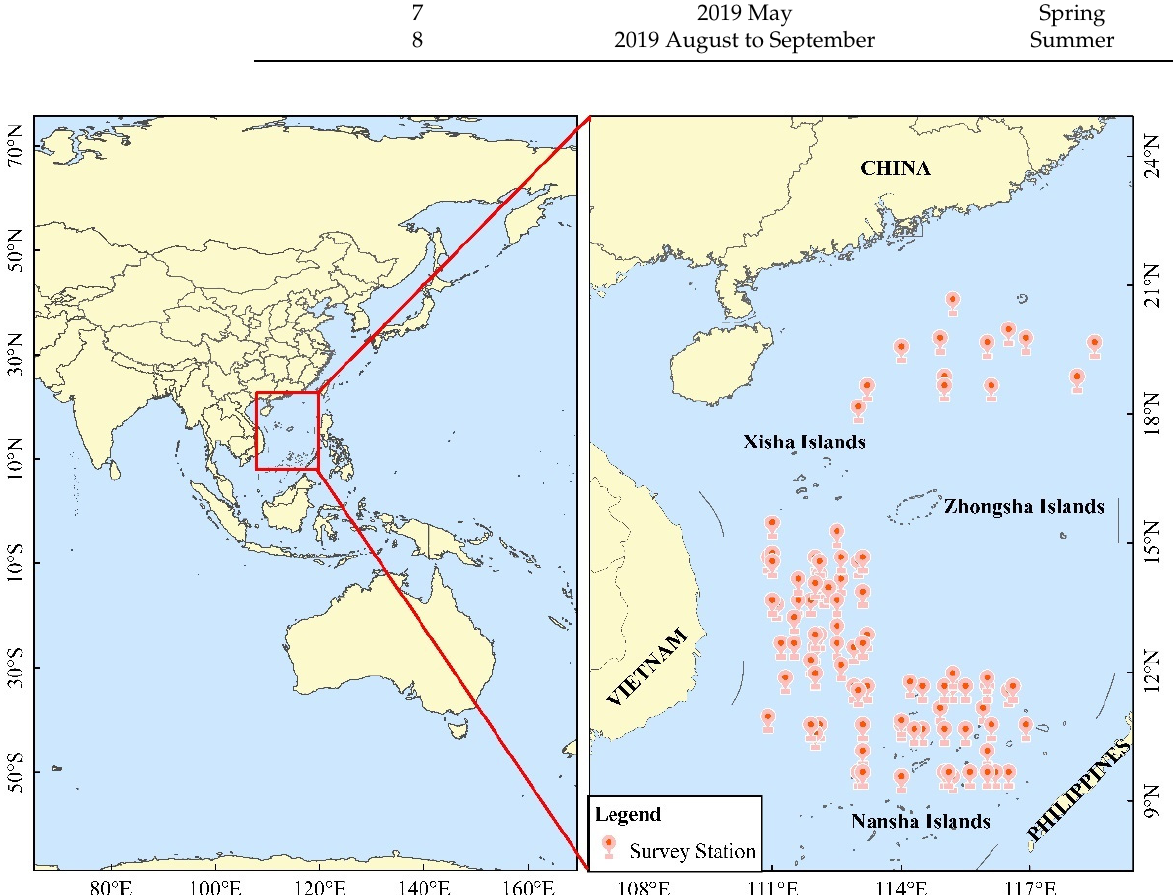
Figure 1. Spatial distribution of survey stations for A. thazard in the South China Sea, spring to summer, 2015–2019. Inset with red rectangular box marks the study area.